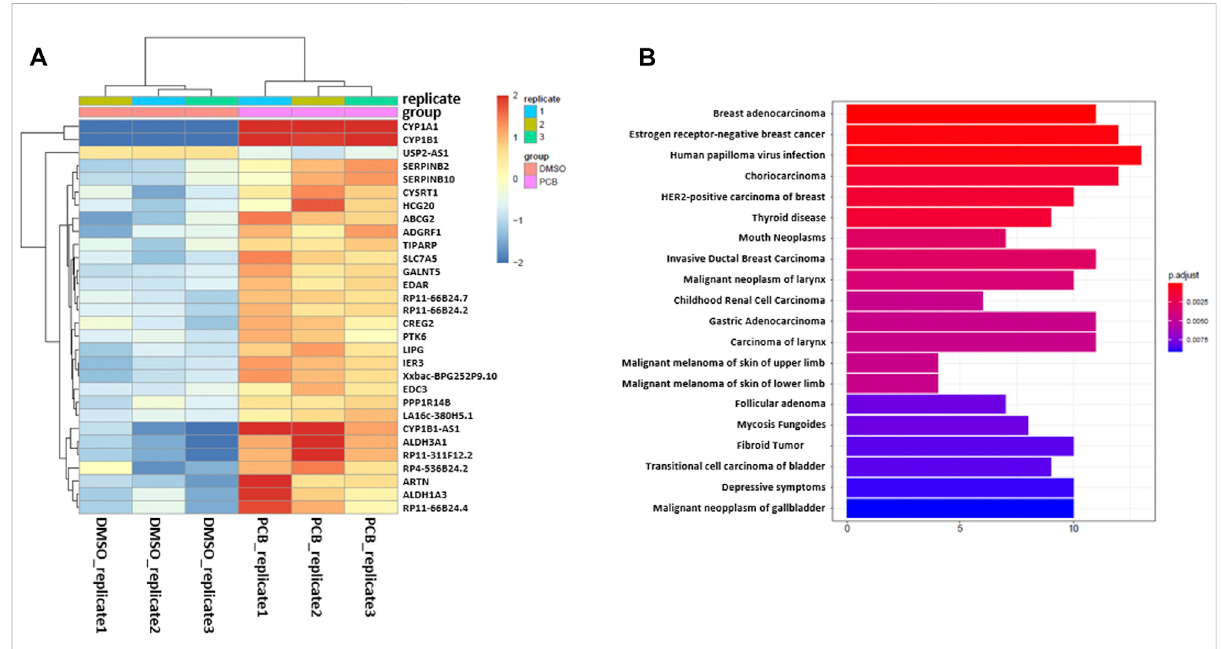
FIGURE 4 Varianceofgeneexpressionandenrichmentanalysis. (A) Heatmapshowingthetop30geneswiththehighestvarianceafternormalizingforthe CPM. (B) Enrichment analysis based on the DisGeNET database, revealing diseases, which are associated with the differentially expressed genes. X-axis shows the number of genes involved in each